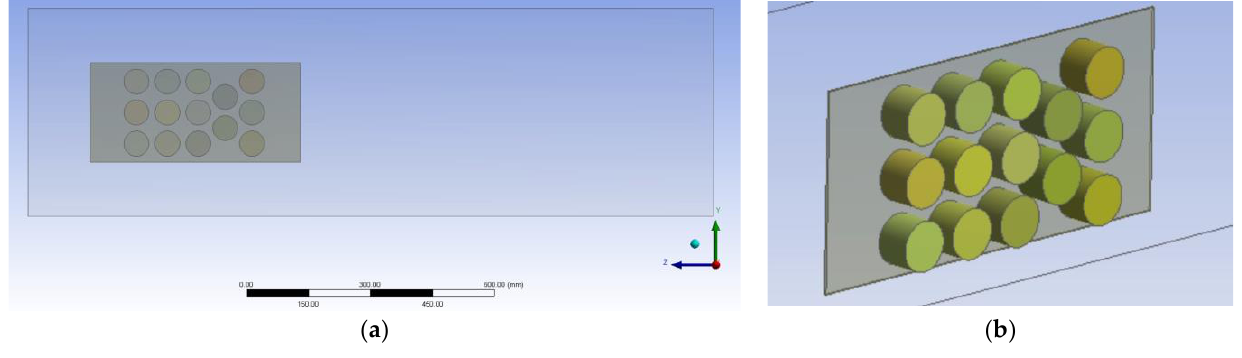
Figure 5. ( a ) Computed domain and ( b ) detail in the SCs